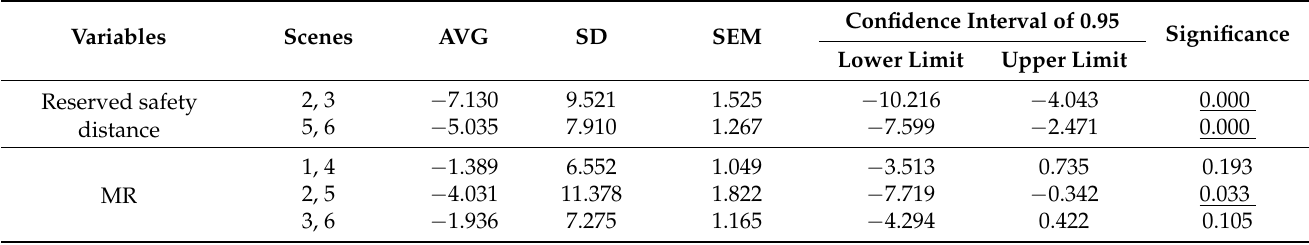
Table 8. Paired sample t -test of mean speed within 5 s after taking